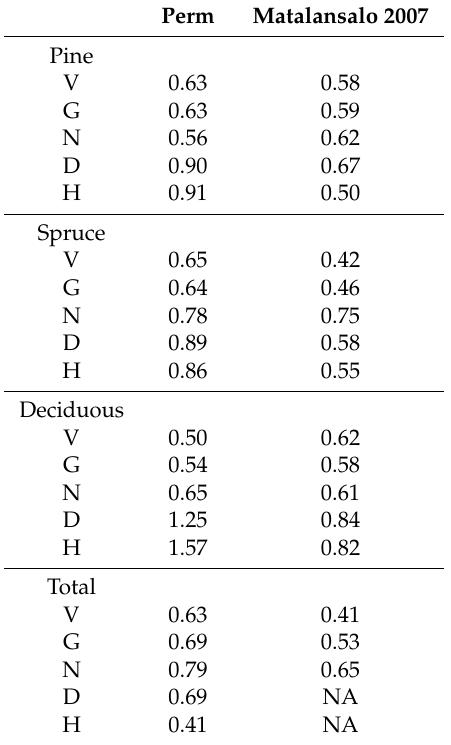
Table 4. Plot level RMSE values relative to the standard deviation in Perm and Matalansalo 2007. Perm Matalansalo 2007 Pine V